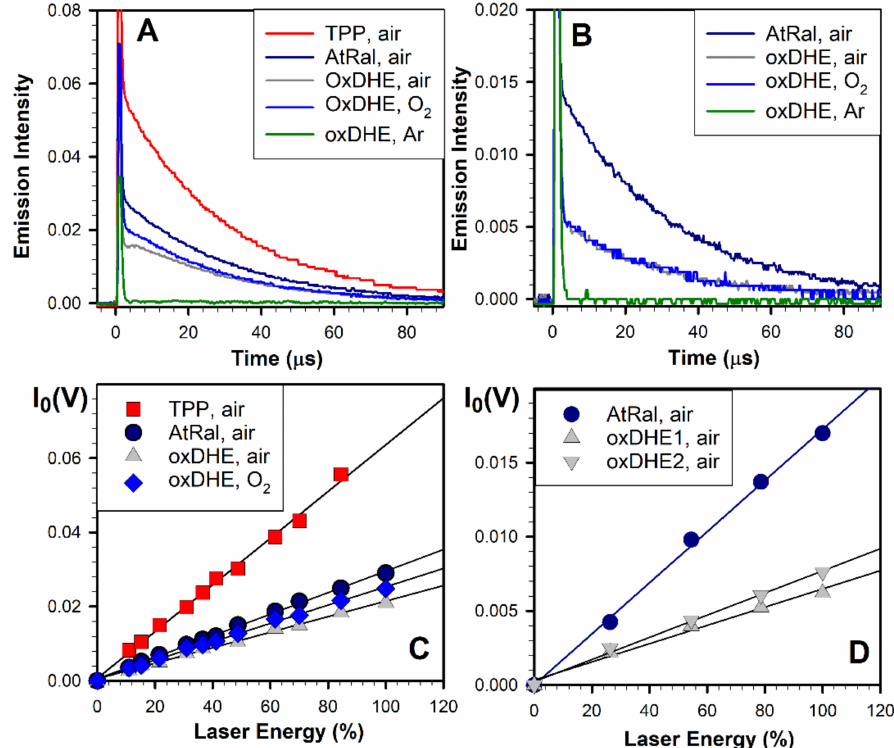
Figure 6. Photoexcitation of oxidised DHE (OxDHE) with a 5 ns laser pulse results in oxygen- dependent infrared emission at 1270 nm decaying with the characteristic for singlet oxygen lifetime and relatively high quantum yields. Representative kinetics of formation and decay of near-infrared emission after photoexcitation of OxDHE with a 355 nm ( A ) and 425 nm ( B ) 5 ns laser pulse. OxDHE was solubilised in benzene saturated with either air, oxygen, or argon. All- trans -retinal (AtRal) and tetraphenylporphyrin (TPP) were used as standards of known quantum yields of singlet oxygen generation in benzene. To ensure the same number of absorbed photons by samples containing OxDHE and standards, the samples were diluted to have their absorbances adjusted to the same value at the excitation wavelength. The decays of singlet oxygen phosphorescence were fitted with exponential decay functions to obtain, as fitted parameters, the initial intensities of singlet oxygen phosphorescence. ( C , D ) The initial intensities, I 0 plotted as a function of laser energy. Straight lines were fitted to datapoints within the linear range of I 0 increase with laser energy. The ratio of the quantum yields of singlet oxygen generation by OxDHE and a standard is the same as the ratio of their corresponding slopes of the fitted straight lines, which allows the calculation of the quantum yield of singlet oxygen generation by